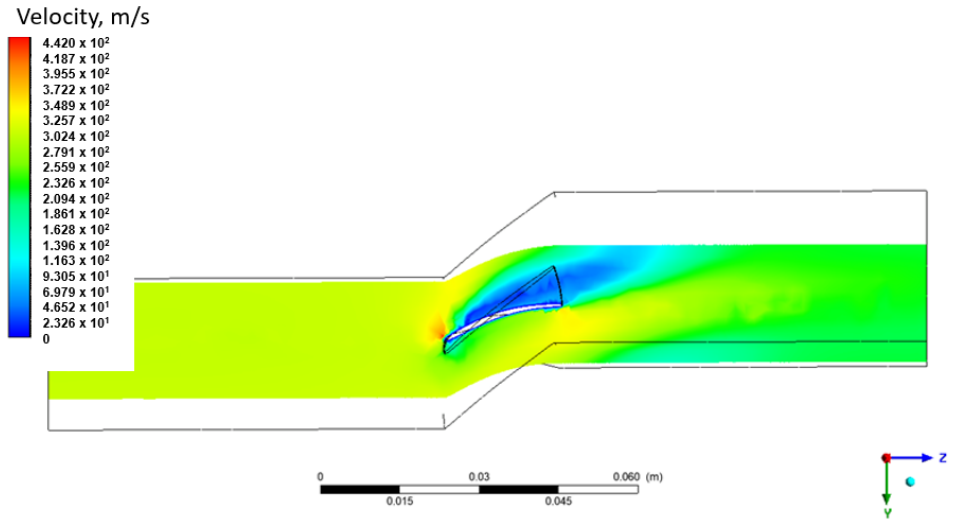
Figure 5. The distribution of the relative velocity (taking into account the rotational speed) in the cross section that covers the fluid domain for the rotational speed of 31,486 RPM (cross-section in 50% of the height of the blade − 76 mm from the axis of rotation).